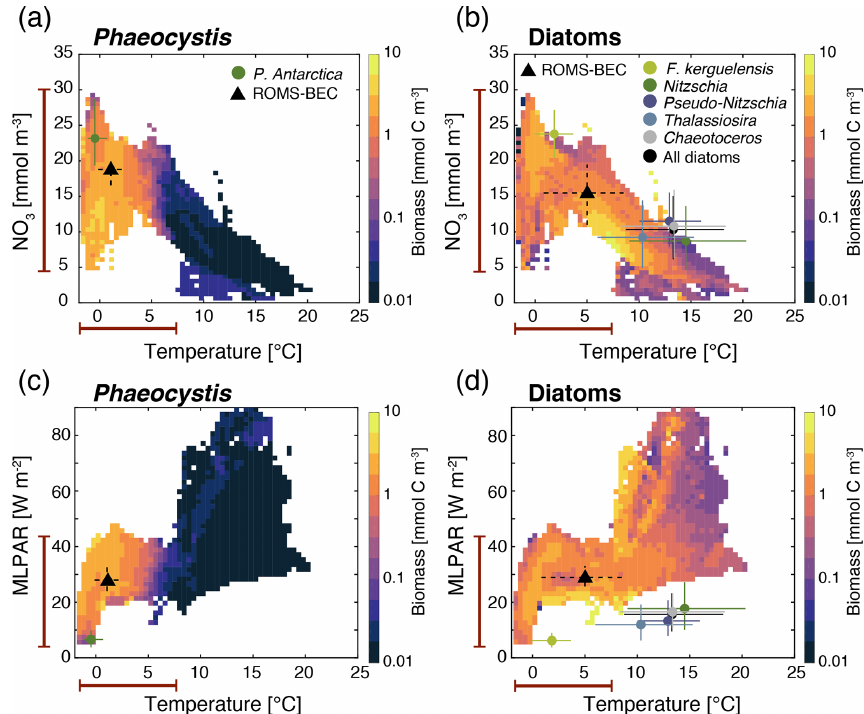
Figure 4. Simulated average DJFM top 50m average (a, c) Phaeocystis and (b, d) diatom carbon biomass concentrations (mmolCm − 3 ) south of 40 ◦ S as a function of the simulated temperature ( ◦ C) and (a, b) nitrate concentrations (mmolNm − 3 ) and (c, d) mixed-layer PAR levels (Wm − 2 ). Overlain are the observed ecological niche centers (median) and breadths (interquartile ranges) for example taxa of the two functional types from Brun et al. (2015) (circles and solid lines) and as simulated in ROMS-BEC (triangles and dashed lines; area- and biomass-weighted). The red bars on the axes indicate the simulated range of the respective environmental condition in ROMS-BEC between 60–90 ◦ S and averaged over DJFM and the top